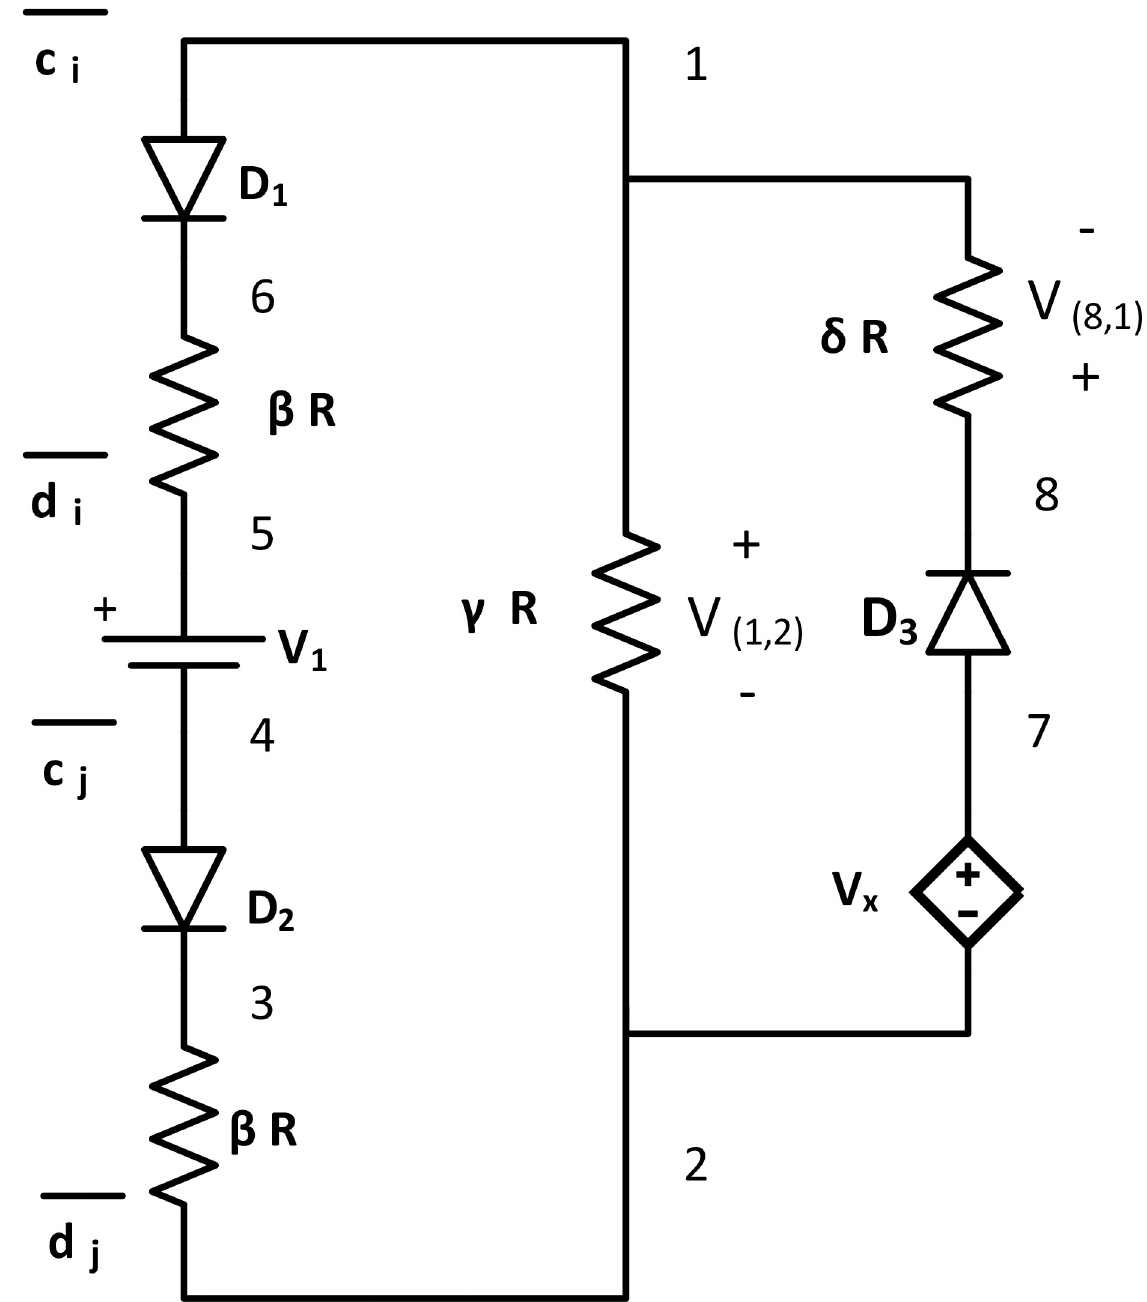
Fig 8. NAND tile. NAND tile consists of three ideal diodes (Diode D 1 , D 2 have V resistors, one γ R resistor, and one δ R resistor, where δ > > γ > > β > > R ), and two voltage sources (One DC voltage source V 1 = τ , and one dependent voltage source of V ¼ 2 tn 0 ). It has two input terminals across node pairs {1, 5} and {4, 2}, and the output terminal at {8, 1}. Glues: x n 0 g ; g ð 2 Þ ¼ f � d g ; g ð 4 Þ ¼ f � c g ; and g ð 5 Þ ¼ f � d g g ð 1 Þ ¼ f � c i j j i